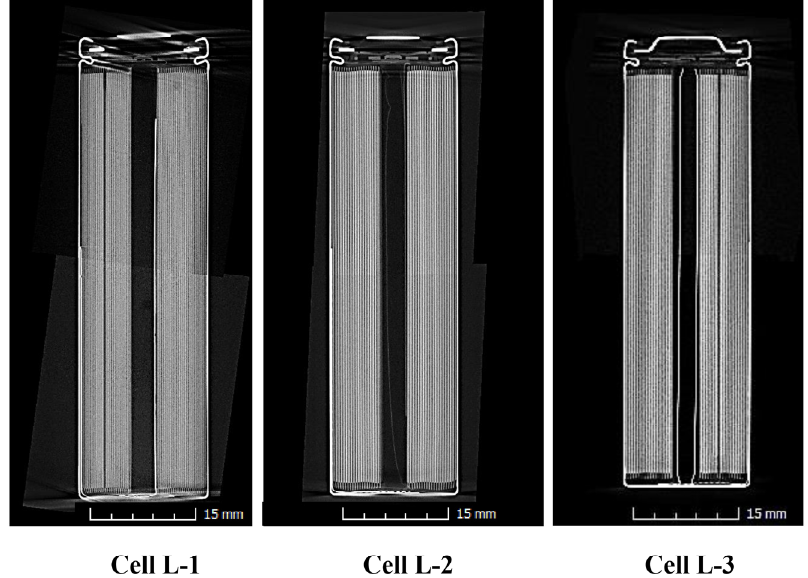
Figure 7. CT images showing the inner structures of cells L-1, L-2, and